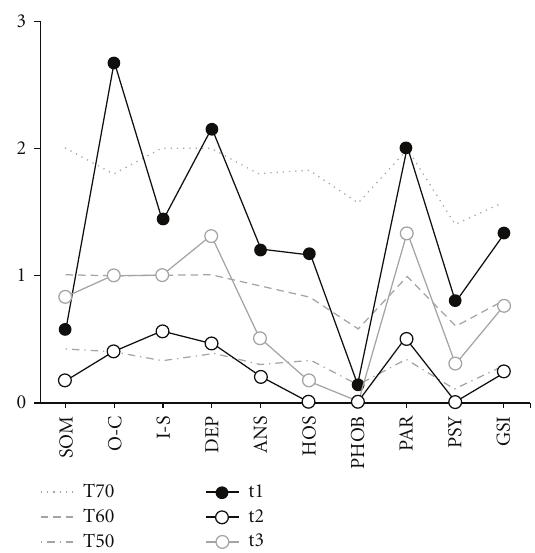
Figure 1: Illustration of the patient’s self-assessment using the symptoms checklist SCL-90 R at 3 measurement points: start of inpatient therapy (t1), end of inpatient therapy (t2), and follow- up (t3). All 9 subscales (SOM: somatization, O-C: obsessive- compulsive, I-S: interpersonal sensitivity, DEP: depression, ANS: anxiety, HOS: hostility, PHOB: phobic anxiety, PAR: paranoid ideation, and PSY: psychoticism) and the GSI (Global Severity Index) are presented. Specifically, the subscales of compulsiveness, depression, and paranoia are elevated. At the end of therapy, the patient’s values lie very close to the mean values of the healthy population in all scales. While the subscales of depression and paranoia have slightly increased again at the end of her treatment, they remain far below the initial values. (T50, T60, and T70: thresholds for the standard female German population. T60 is considered as “clinically suspicious” and T70 as “clinically relevant.” For the GSI, the T60 is already considered as “clinically